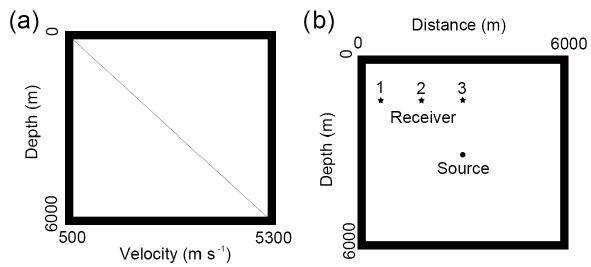
Figure 2. (a) Velocity profiles in depth and (b) distribution of source and